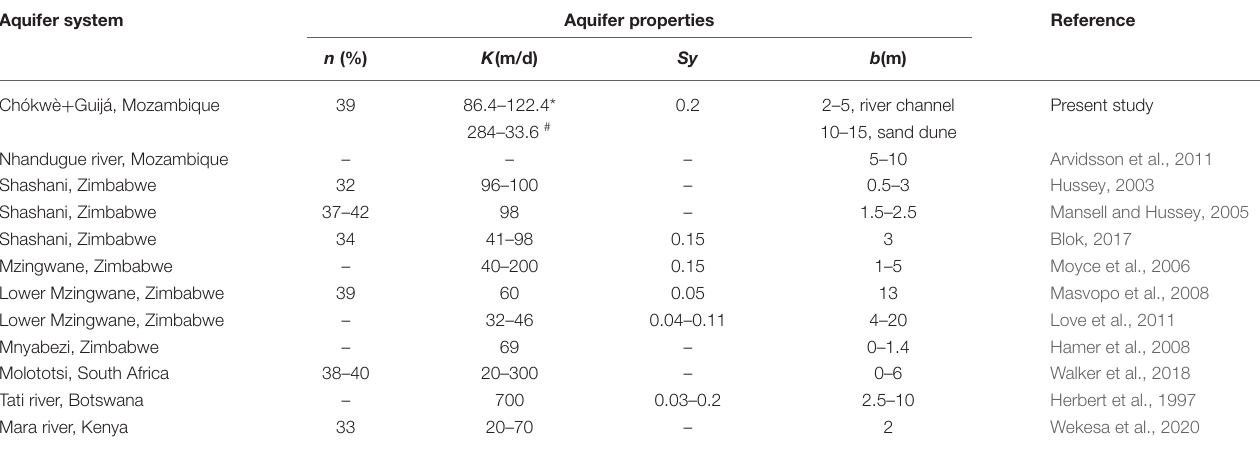
TABLE 4 | Physical characteristics of different sand rivers aquifer